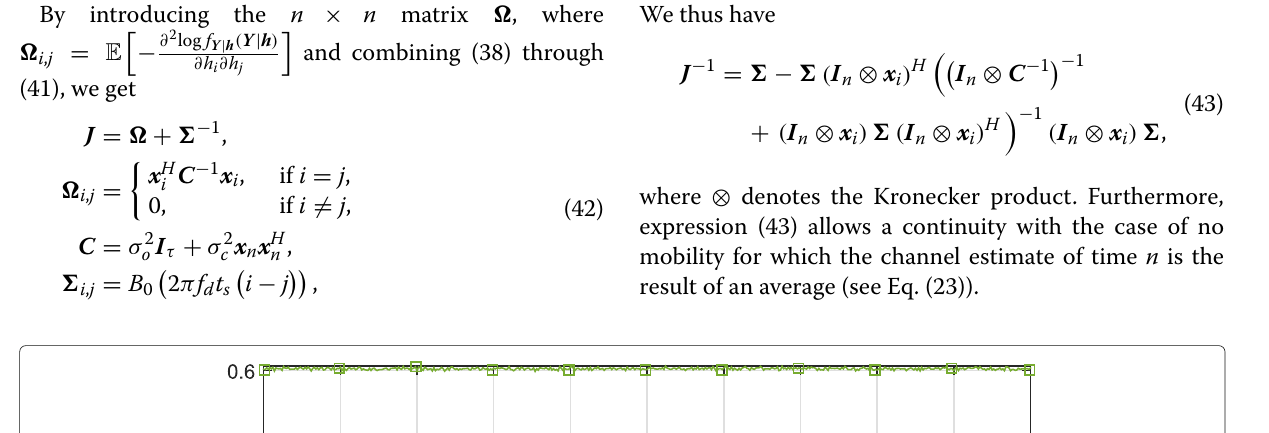
covariance matrix. The CRLB at time n is the correspond- ing submatrix of J − 1 ; it gives a lower bound on channel estimation at time n accounting for the past observations.